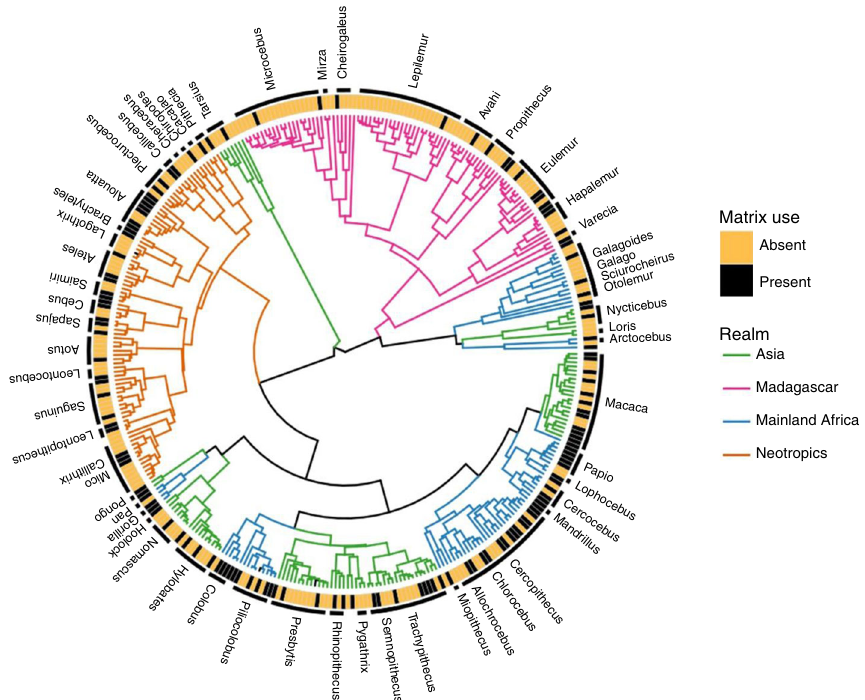
Fig. 5 Distribution of the use of anthropic land covers (ALCs) across the primate phylogeny. Use of ALCs (present/absent) is indicated for each of the 352 species with phylogenetic data, based on the molecular timetree of Dos Reis et al. 50 . All genera with ≥ 2 species are labeled, and branches are color- coded by